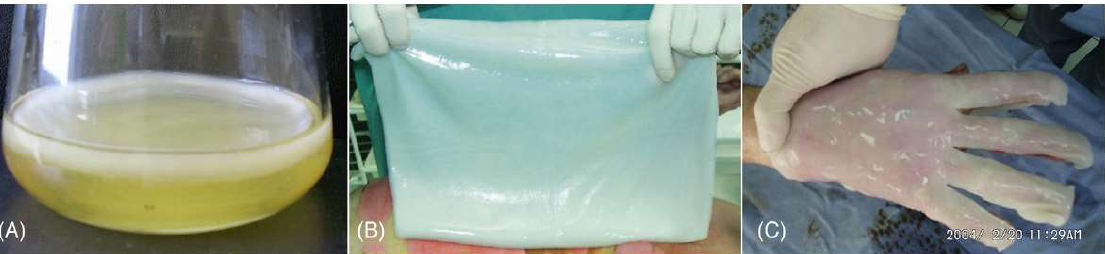
Figure 2. Medical and cosmetic applications of bacterial nanocellulose: ( A ) cellulose layer grown on the top of bacterial culture; ( B ) wound dressing prepared form purified cellulosic membrane; ( C ) application of cellulose hydrogel patch (clinical context) in a burn injury. Reprinted with permission from Ref. [3], 2016, Elsevier Ltd.